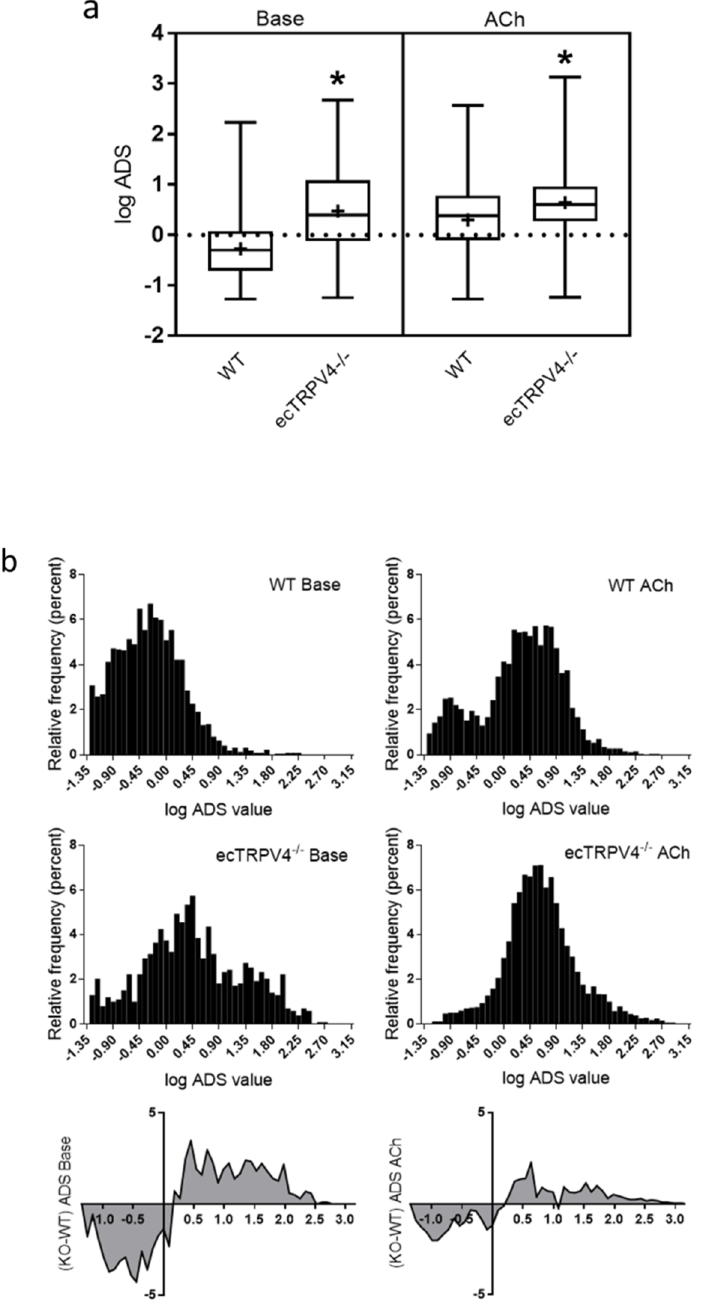
Figure 4. Holo-Ca 2+ event profiling using ADS composite distributions. ( a ) Box-and-whisker plots of log ADS product values for ecTRPV4 −/− and WT under basal conditions and following stimulation with ACh (lines indicate medians and pluses indicate means). * denotes p < 0.05. ( b ) Histograms of log ADS values show full composite event distributions under base (left) and ACh-stimulated (right) conditions; the bottom panel shows difference plots between the ecTRPV4 −/− and WT histograms.